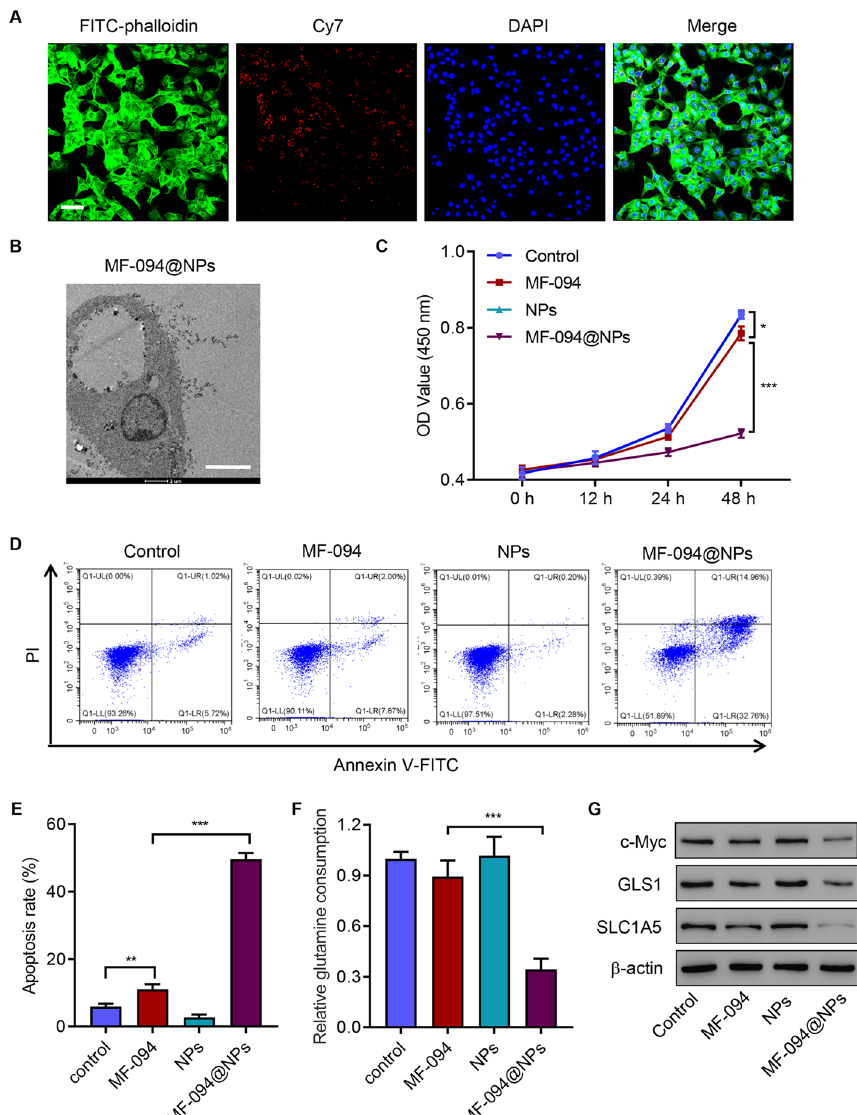
Fig. 6 NPs enhance the anticancer effects of MF-094 in HSC4 cells. A CLSM images (scale bars: 50 μm). B TEM images showing intracellular distribution of MF-094@NPs in HSC4 cells (scale bars: 4 μm). C Cell viability, D and E apoptosis, F glutamine consumption, and G expression of c-Myc, GLS1, and SLC1A5 in HSC4 cells incubated with MF-094, NPs, and MF-094@NPs. * P < 0.05, ** P < 0.01, *** P <